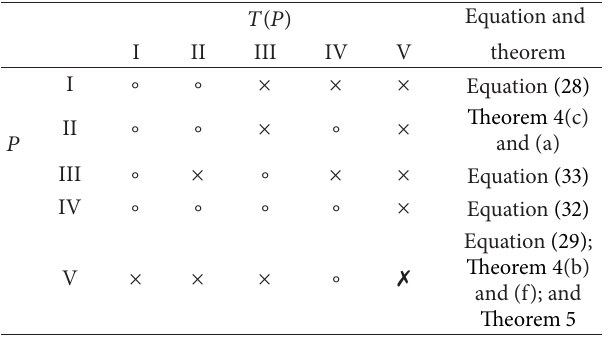
Table 1: The regions containing 𝑇(𝑃) . The symbols I to V denote the regions defined in (11). The region I in the second column denotes 𝑃 ∈ I, the symbol × at (𝑃,𝑇(𝑃)) = ( I , III ) means 𝑇(𝑃) ∉ III, and then the two circles ∘ together at both (I, I) and (I, II) denote that 𝑇(𝑃) ∈ I ∪ II by (28). The symbol M denotes that 𝑃 ∈ V and 𝑇 𝑚 1 (𝑃) ∉ V for some 𝑚 1 by Theorem